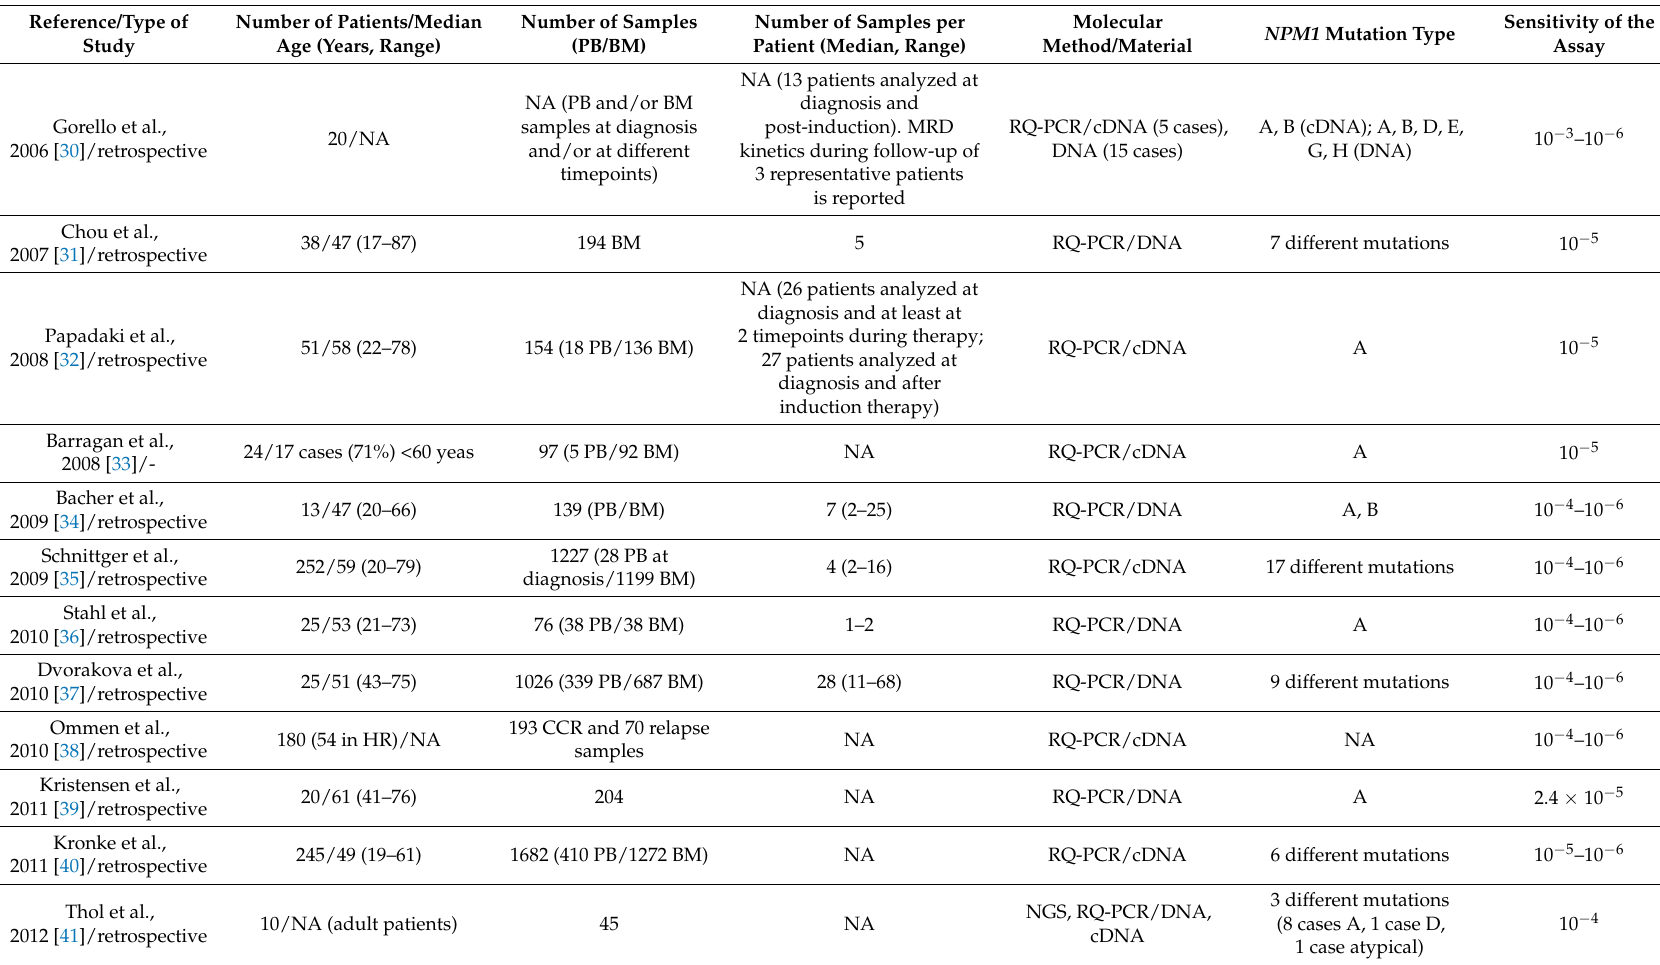
Table 1. MRD monitoring in NPM1 -mutated AML series: review of the